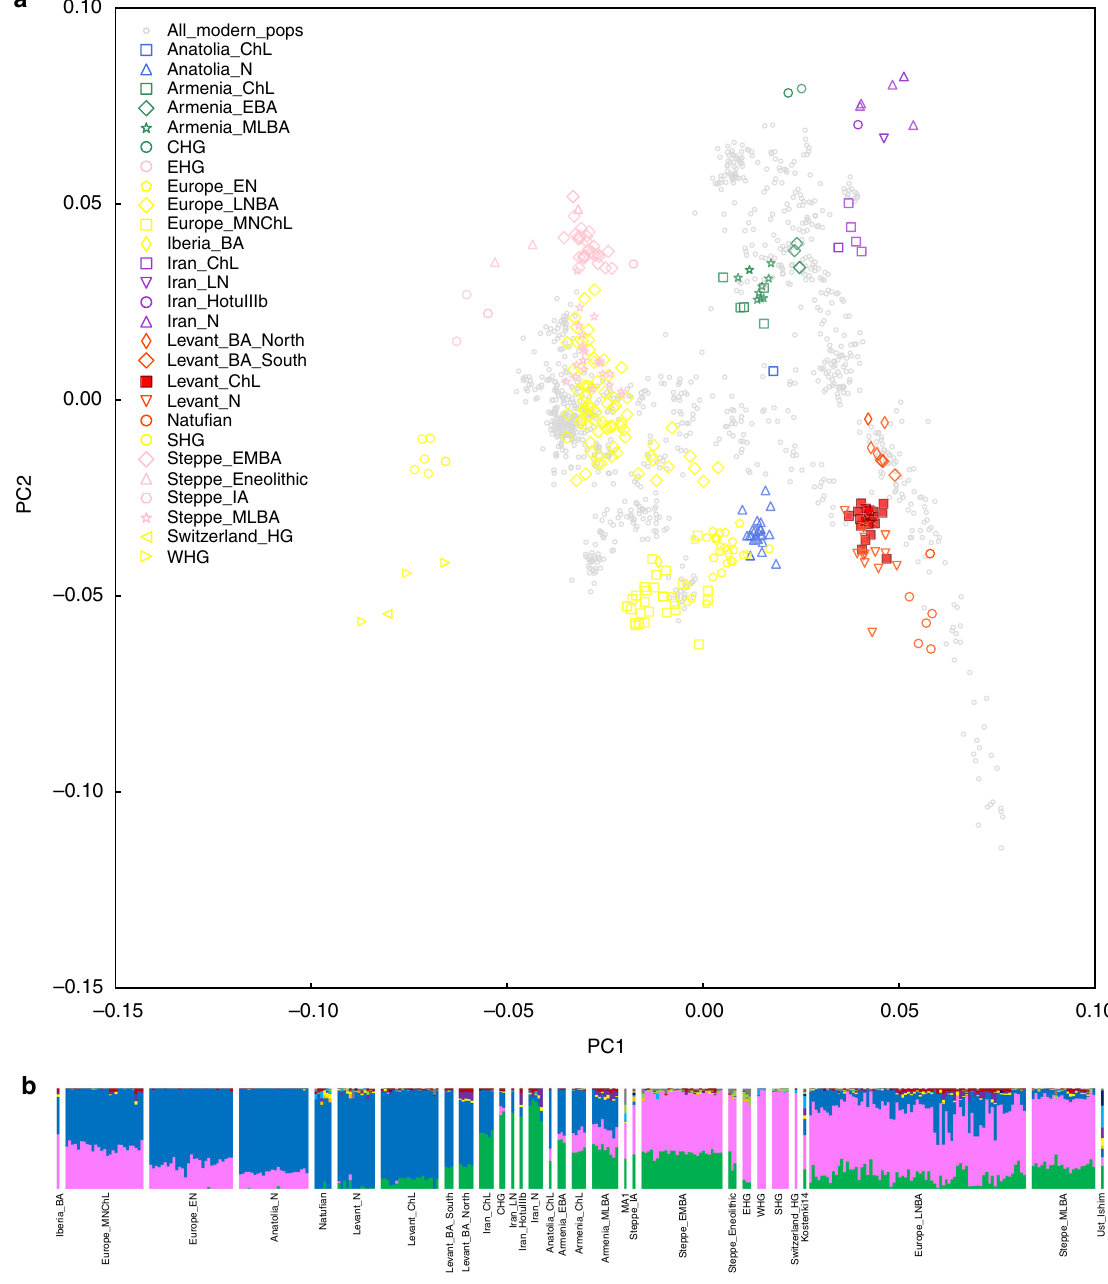
Fig. 3 Genetic structure of analyzed individuals. a Principal component analysis of 984 present-day West Eurasians (shown in gray) with 306 ancient samples projected onto the fi rst two principal component axes and labeled by culture. b ADMIXTURE analysis of 984 and 306 ancient samples with K = 11 ancestral components. Only ancient samples are